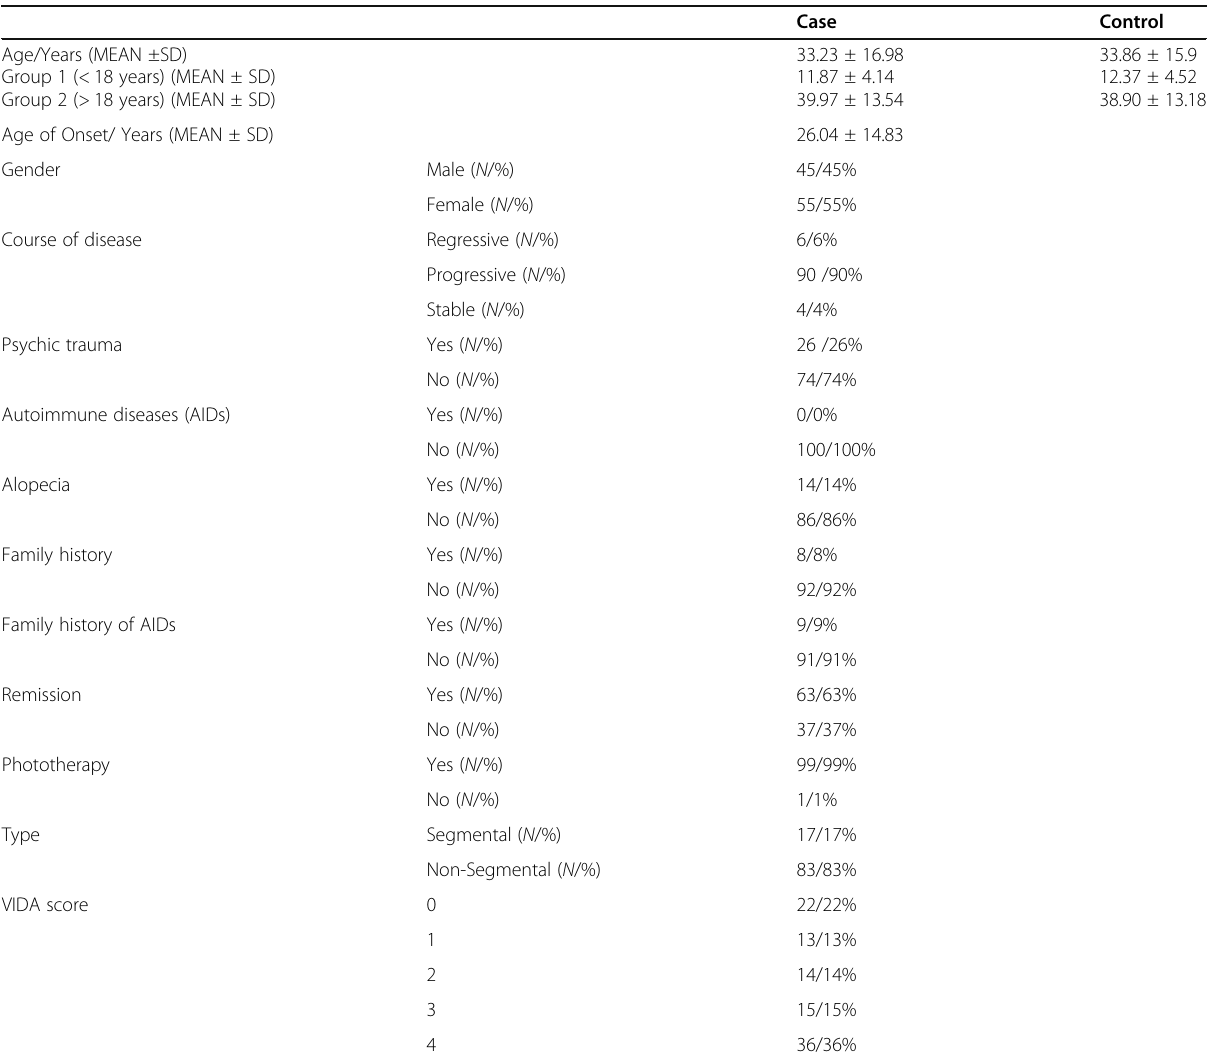
Table 2 Demographics characteristics of vitiligo patients